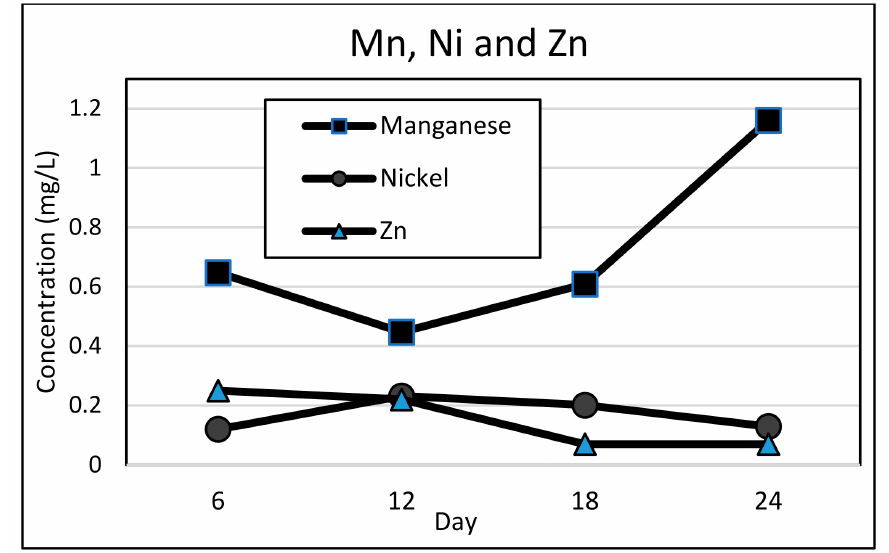
Figure 11. Treated Mn, Ni, and